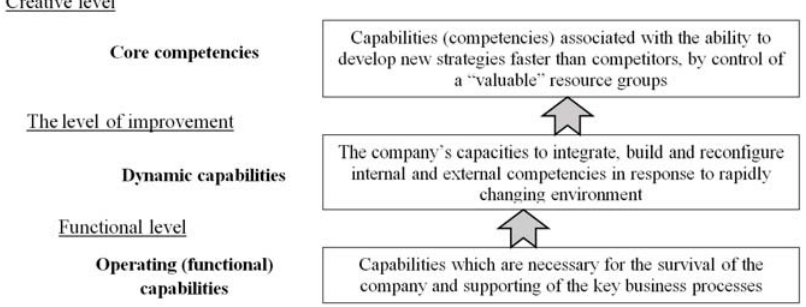
Fig. 2. The hierarchy of organizational capabilities, developed by the